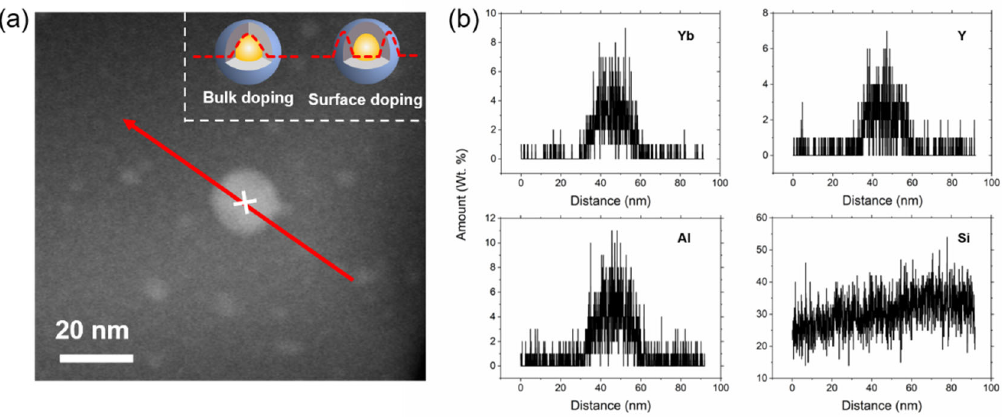
Figure 5. ( a ) Illustration of a typical line ‐ scan for a single nanocrystal. The red line shows the cross ‐ section used for the EDX chemical analysis. A point 50 nm from the beginning of the line is marked with a white cross. The inset shows the ideal distribution curves of bulk and surface doping of REs in nanocrystals. ( b ) Linear profile of the chemical composition, i.e., the amount of Yb, Al, Y, and Si in wt.%.